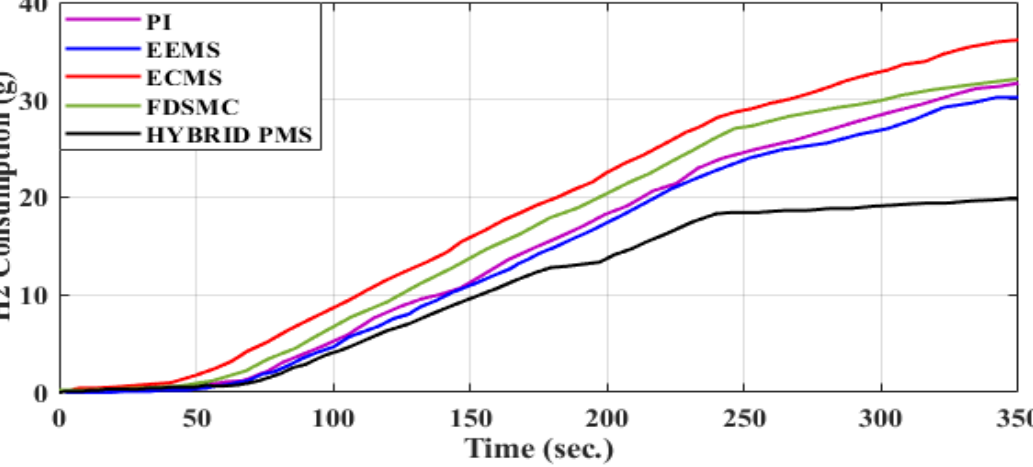
Figure 13. System efficiency and hydrogen consumption for each scheme (WLTP — Class 3 Drive Cycle).